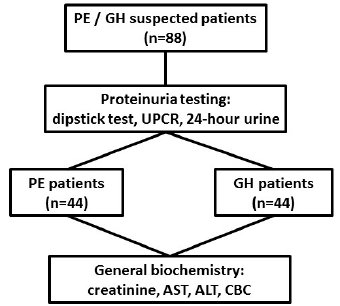
Figure 1. Study flow diagram. Patients were classified into two groups based on clinical features and